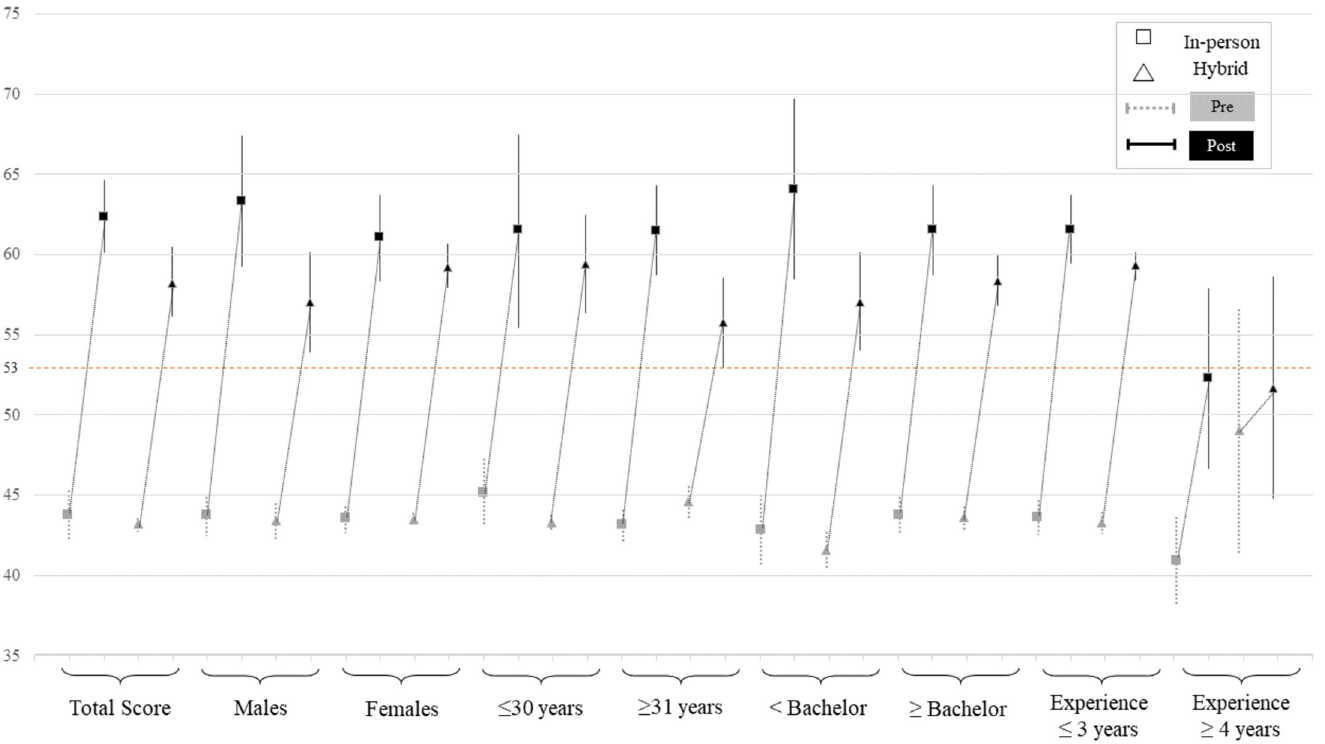
Fig 2. Adjusted pre- and post-test scores mean with their 95%confidence intervals by type of intervention.